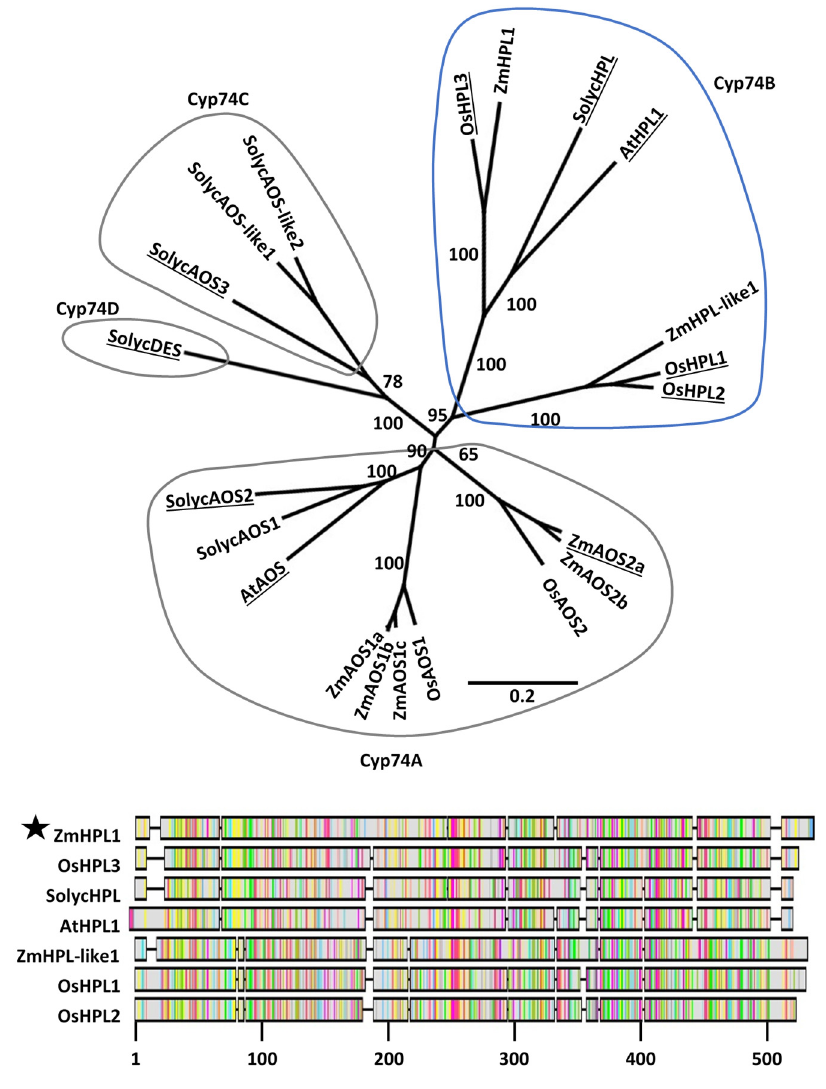
Figure 2. Phylogenetic analysis of the Cyp74 gene families of Arabidopsis, tomato, rice, and maize. The Neighbor-joining tree was constructed using MUSCLE alignments of predicted protein sequences based on primary transcripts of each gene. Enzymes for which biochemical activity has been experimentally determined are underlined. Cyp74 subfamilies are circled. ZmHPL1 falls within the Cyp74B subfamily and is closely associated with biochemically validated HPLs. Relevant bootstrap values (1000 repetitions) are shown. The scale bar indicates substitutions per site. The alignment includes predicted protein sequences of the seven Cyp74B members of maize, rice, tomato, and Arabidopsis. The most highly conserved regions of amongst Cyp74B members are between positions 40 and 110 and from positions 310 to 490.